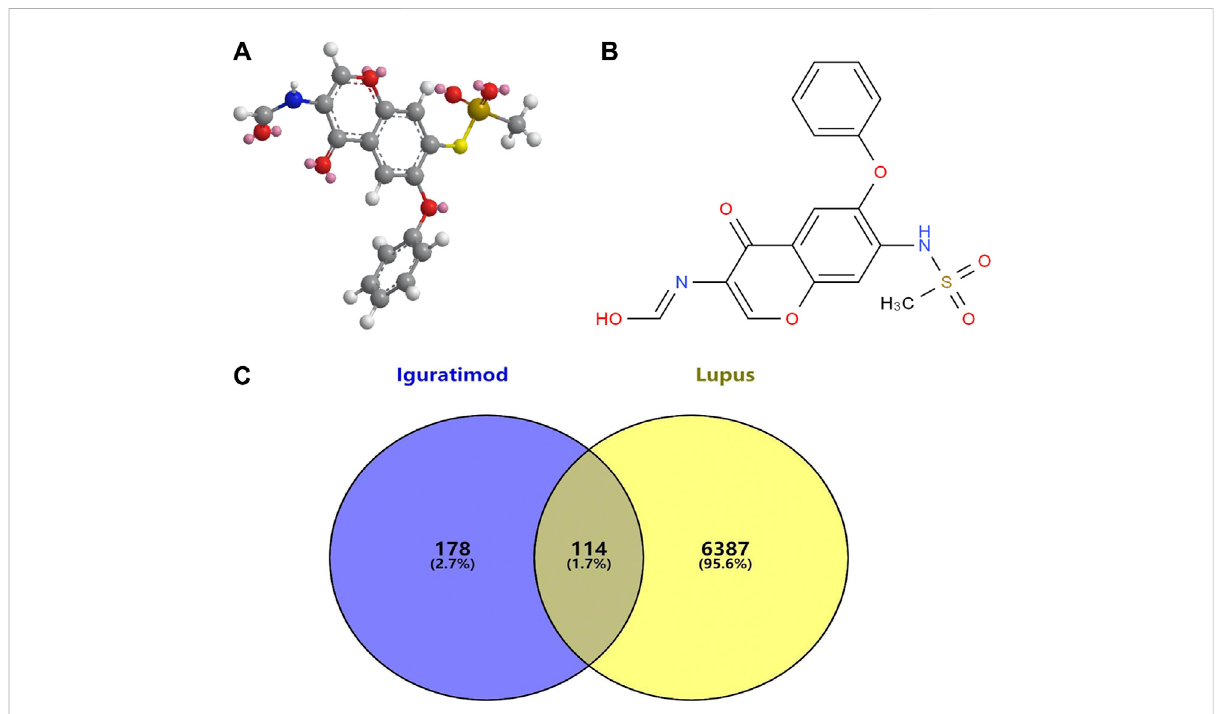
FIGURE 2 Associated targets predicted from databases involved in IGU (Ligand: 124246) and SLE. (A) 3D chemical structures of IGU . (B) 2D chemical structures of IGU . (C) Venn diagram of IGU targets and